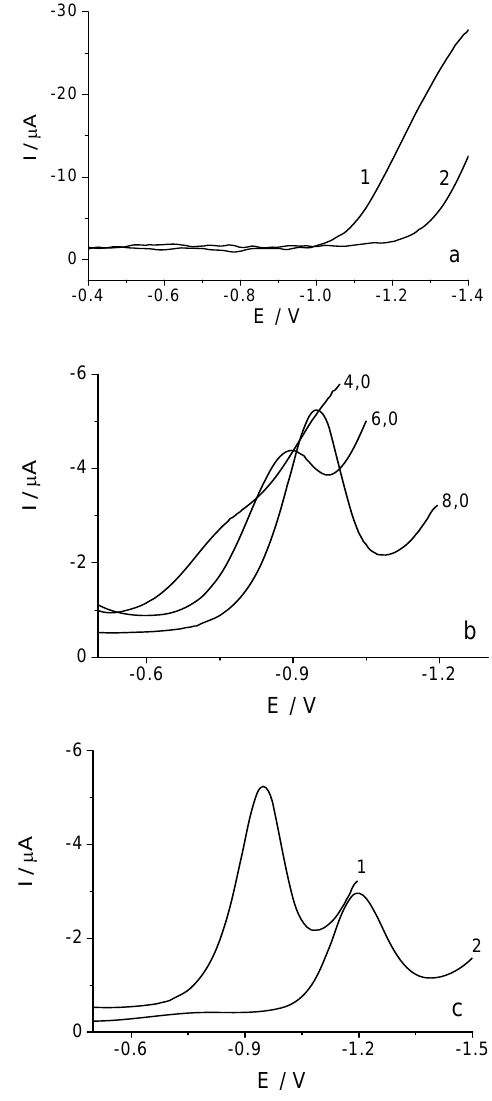
Figure 3. DPV curves at BiF-GCE recorded for the Britton-Robinson blank solutions ( a ) at pH 6.0 (1) and pH 8.0 (2). Clothianidin reduction peak at the pH values indicated on the curves ( b ). Comparison of DPV curves obtained under the same experimental conditions for the clothianidin reduction ( c ) at BiF-GCE (1) and GCE (2) at pH 8.0. Experimental parameters: v = 25 mV s − 1 , pulse amplitude = 50 mV, pulse width = 50 ms ( a - c ); c = 27.05 μ g cm − 3 ( b , c